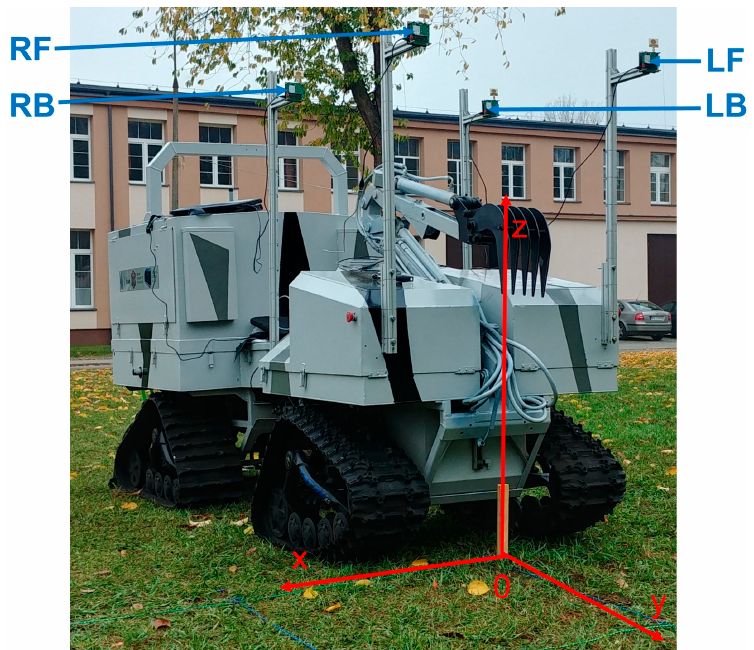
Figure 6. Anchor naming convention and placement on the UGV in and xyz coordinate system.